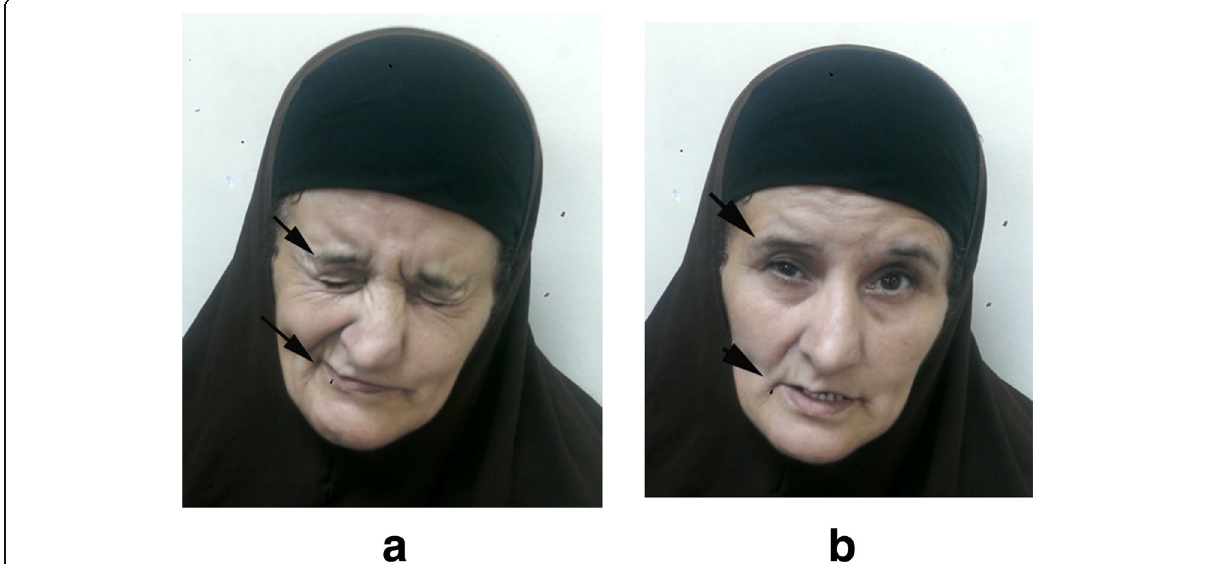
Fig. 1 A case of hemifacial spasm treated medically. a Pre-treatment status: right side hemifacial spasm involving upper and lower face, mouth deviation was observed. b Post treatment status: improvement in hemifacial